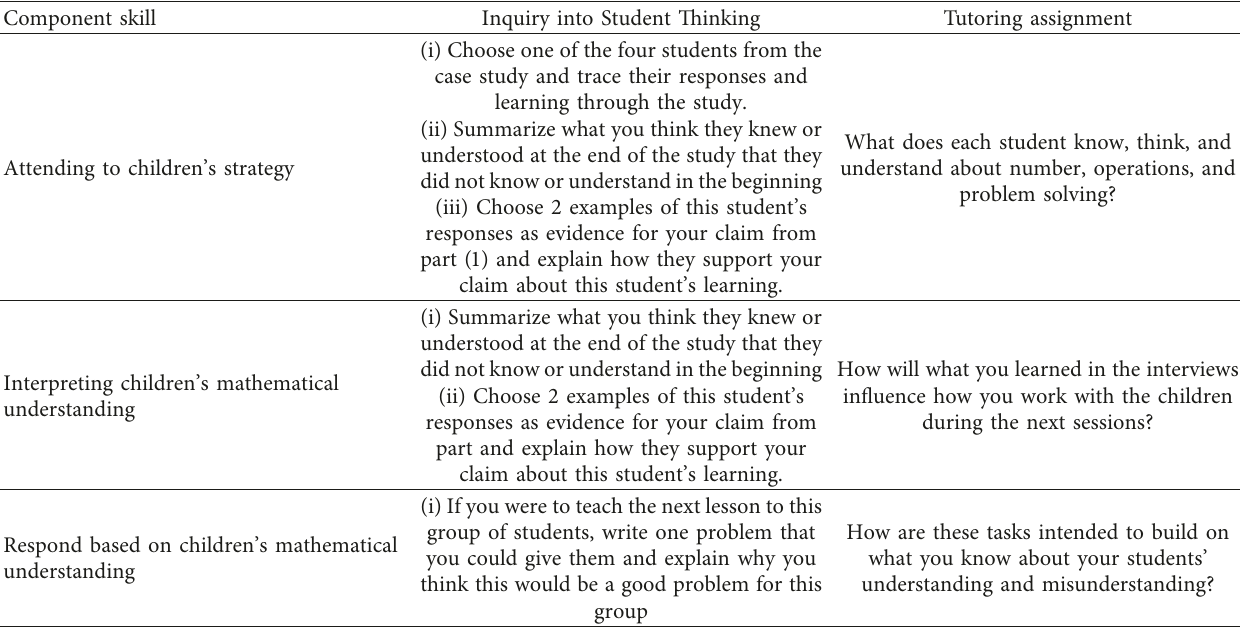
Table 1: Summary of prompts used in the two